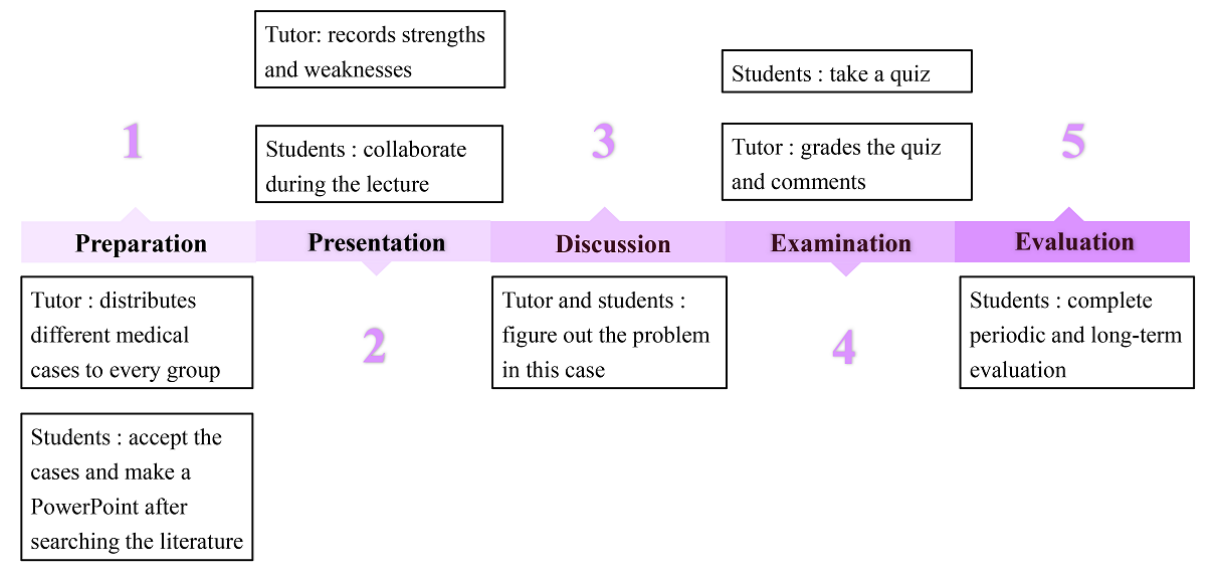
Figure 1. Basic flowchart of the WeChat-PBL teaching